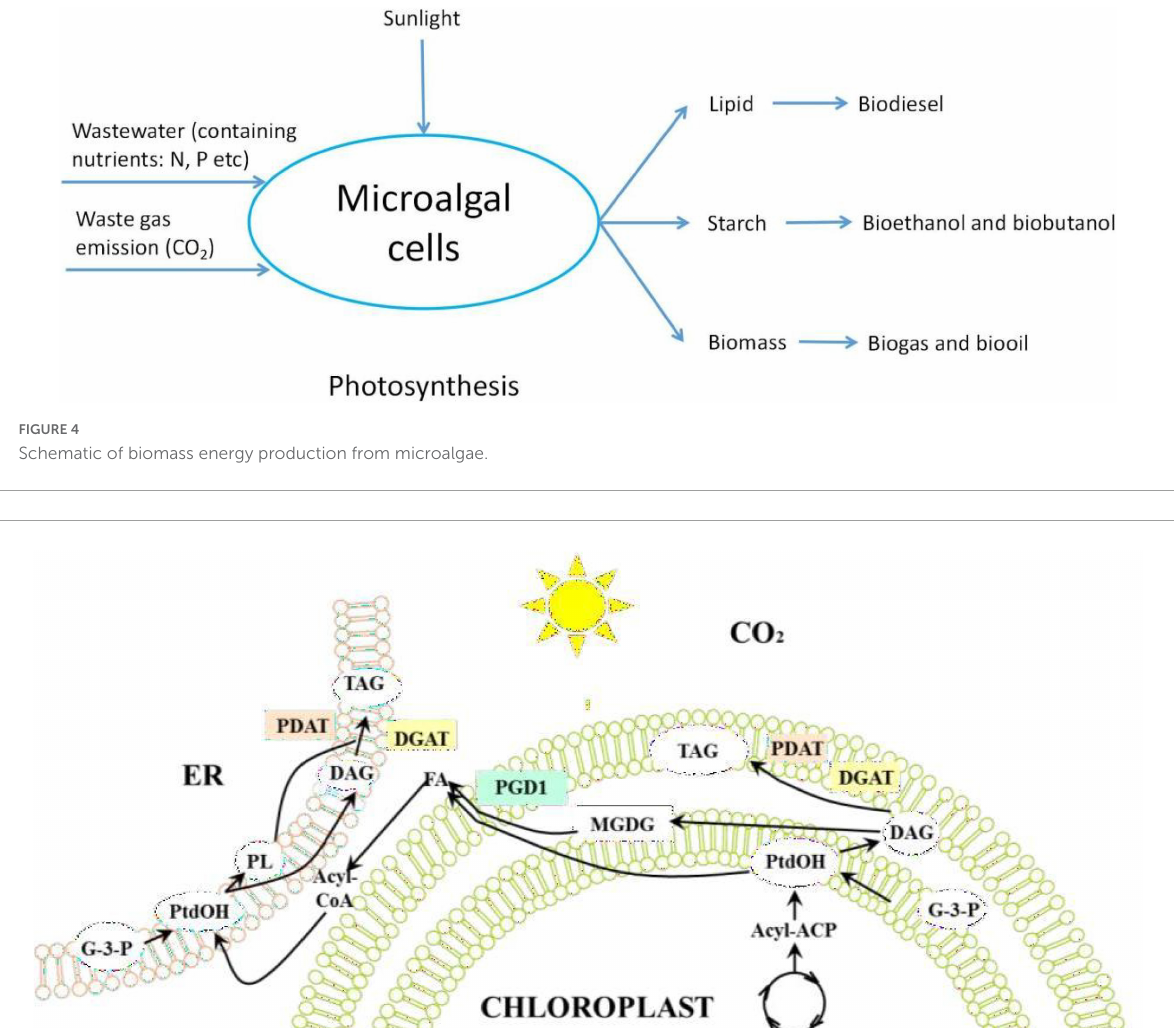
Lipid metabolic pathways